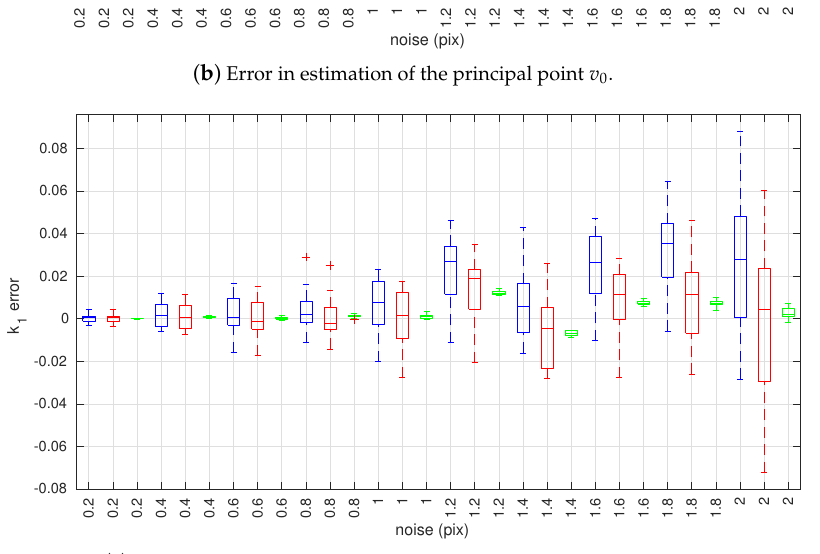
( c ) Error in estimation of camera lens radial distortion coefficient k 1 . Figure 8. Box plots of estimation errors in camera intrinsic parameters w.r.t. camera observation noise. The box plots in blue represent estimation results using the conventional method [19], red plots are of the proposed method without joint optimization, and green plots are of the proposed method with joint